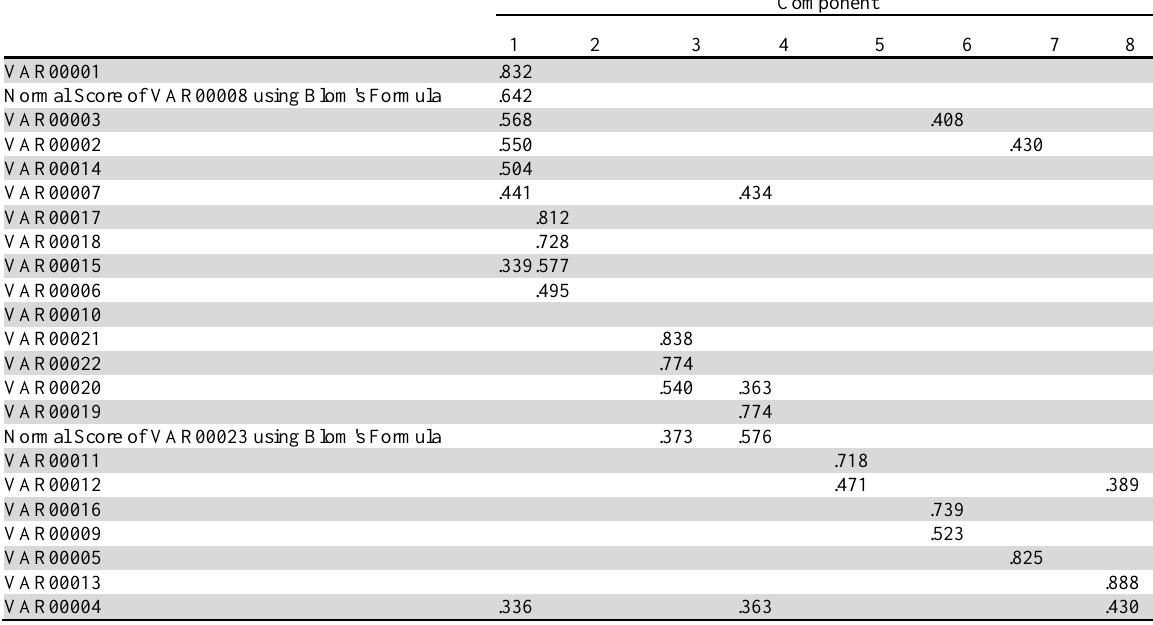
The results of Principal Component Analysis using Varimax with Kaiser Normalization